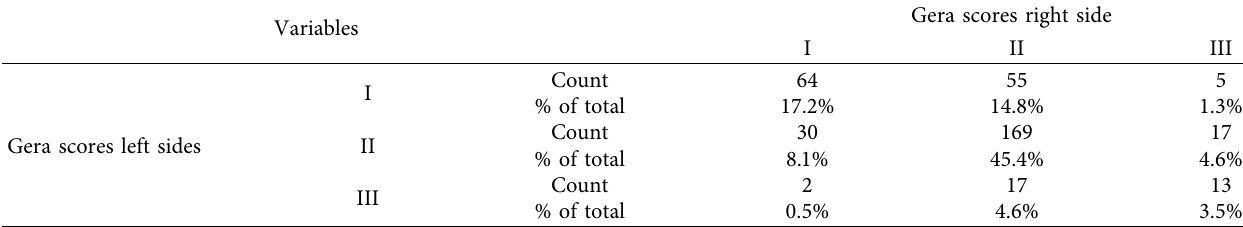
Table 4: Gera scores in the right and left sides.